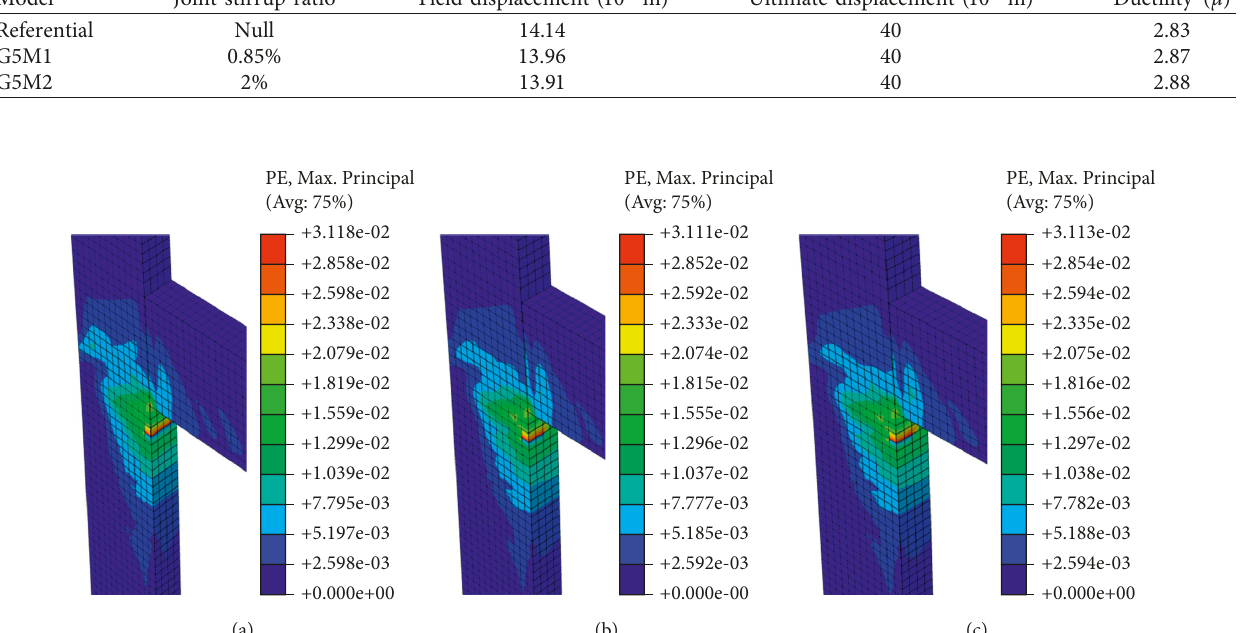
Figure 27: Crack pattern for specimens with different joint stirrup reinforcement ratios: (a) Referential, no shear reinforcement; (b) G5M1, 0.85%; and (c) G5M2, 2%.